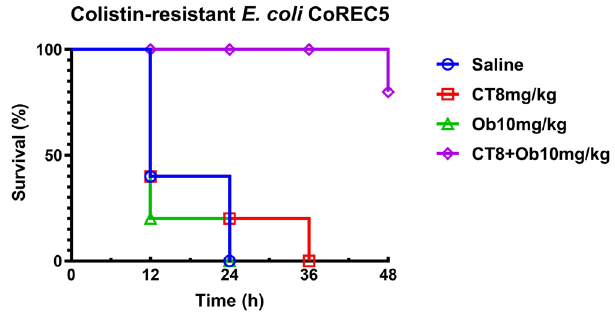
Fig. 3 Assessment of antimicrobial ef fi cacy of the Ob and colistin combination in mouse sepsis model infected with colistin-resistant E. coli CoREC59. The mice were infected with ~10 8 CFU of bacteria and subjected to different treatments including saline, colistin alone (8 mg/kg), Ob alone (10 mg/kg), and a combination of colistin (8 mg/kg) and Ob (10 mg/kg). The number of dead mice was recorded during the experimental period.